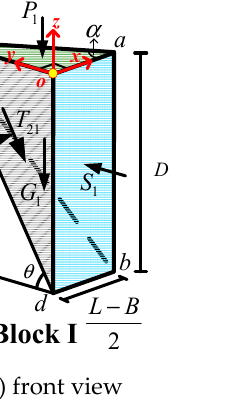
P on the top surface o a e is given by: 1